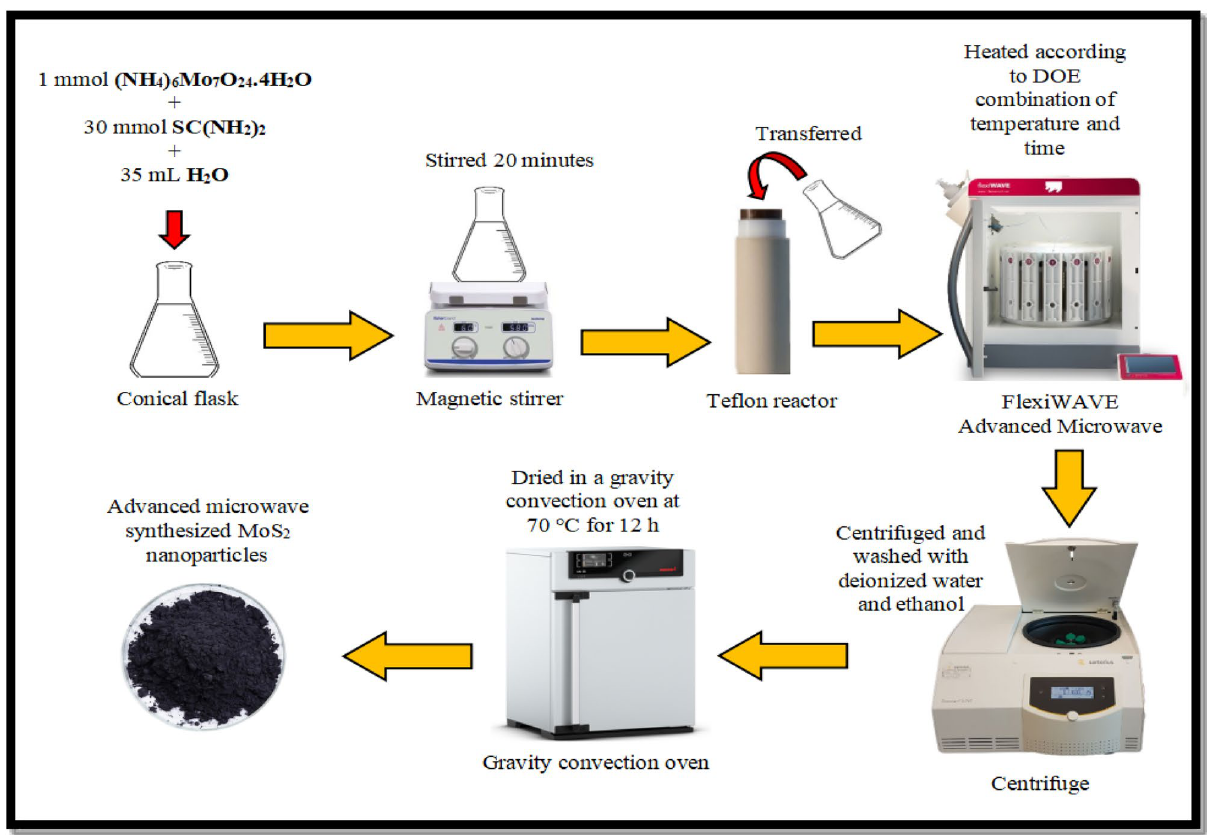
Figure 11. Schematic diagram of MoS 2 nanoparticles preparation via advanced microwave synthesis.